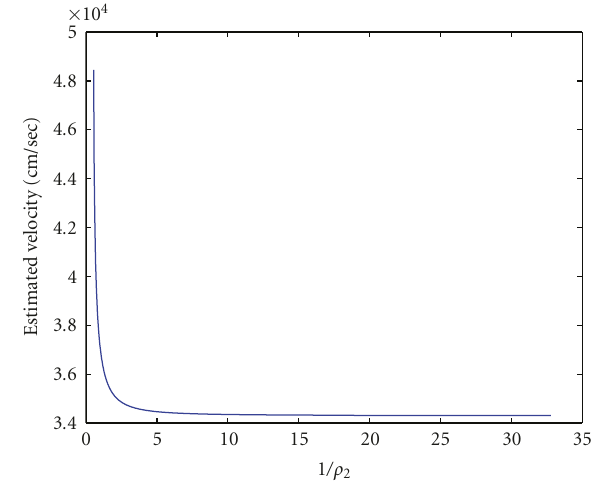
Figure 3: Estimated velocity versus 1 /ρ 2